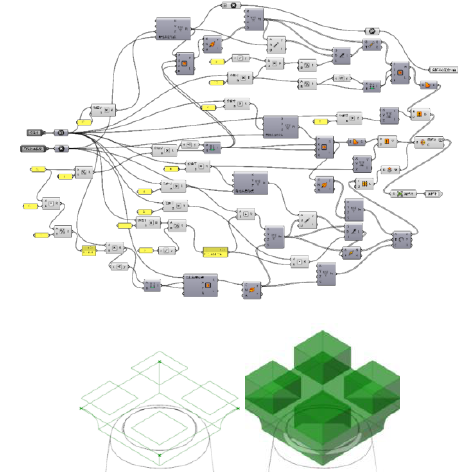
Figure 17. Algorithm battery for bracket set generation